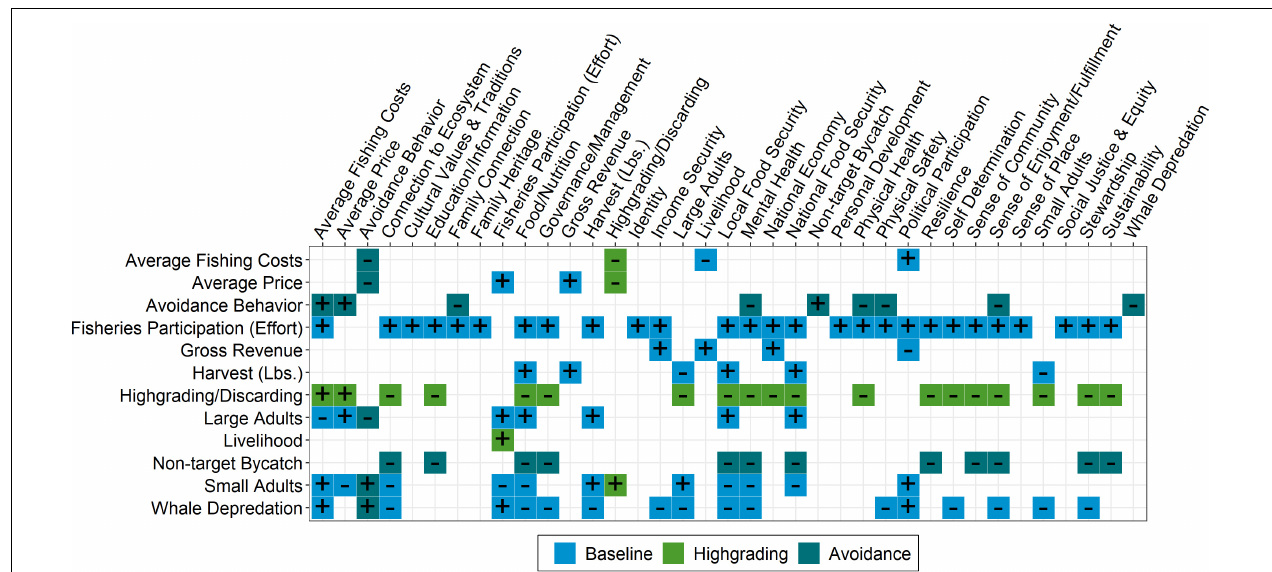
FIGURE 3 | A matrix representation of the variable interactions obtained from the signed digraphs for the baseline, highgrading and avoidance QNMs, derived from stakeholder interviews and literature review. All variables have negative self-interaction (not shown). Symbols within squares indicate the link direction (+, –). Blue boxes indicate links specific to the baseline model, green boxes are specific to the highgrading models and teal boxes apply to the avoidance. Figure created with R package “ggplot2” (Wickham, 2016; R Core Team, 2019). The highgrading model includes all of the links in the baseline model; the avoidance model includes all of the links in the highgrading and baseline